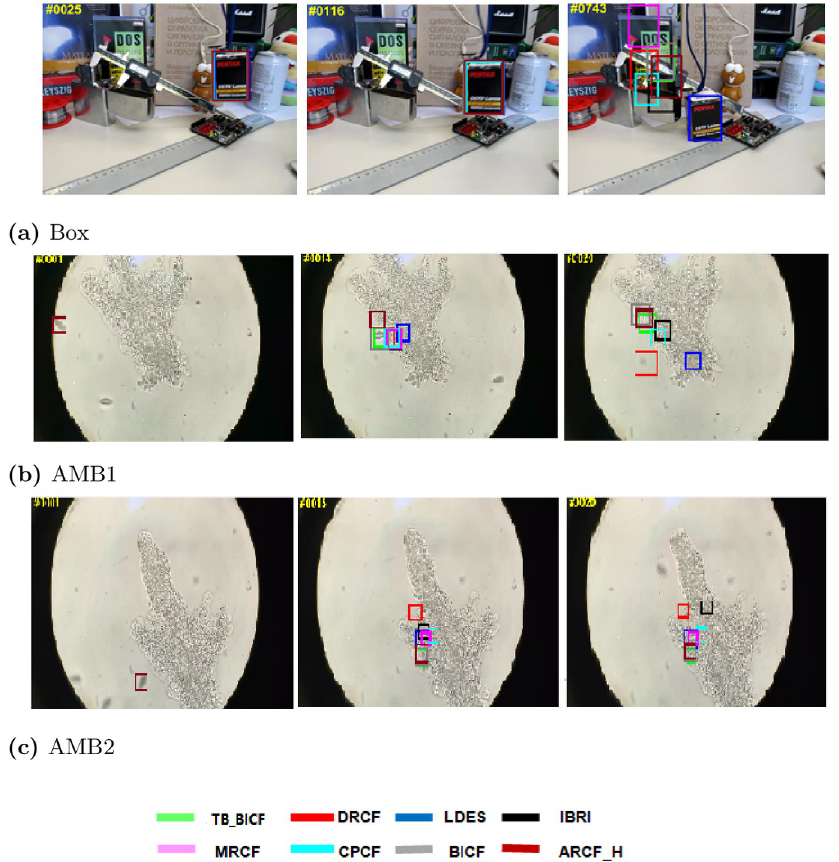
Fig 7. Qualitative assessment of the tested trackers on the a) Box [8], b) AMB1 and c) AMB2 sequences. number of features per sequence. Table 2 lists the the eight trackers’ average frame per second results for each tracker where the running times can be classified into three groups, namely, 1) slow, 2) fast, and 3) normal. The slow group of the largest running times trackers includes LDES and IBRI. The slowest performance of the LDES tracker can be linked to the idea, which is proposed by LDES, of using two boundary boxes to track the object of interest. This pro- posed idea of using two boundary boxes increases the running time drastically. The slow run- ning time of IBRI tracker can be linked to the extended use of historical frames to track the object. The main motivation of IBRI tracker was that most of the existing methods combine the information of only two successive video frames; thus, IBRI extended the number of used frames at the cost of the running time. The fast group of the trackers includes the CPCF tracker only with almost 12 frames per second. The fast performance the CPCF tracker can be justified by utilizing two fast to compute two features, HoG and CN; computing those two features Table 2. The average fps for the eight trackers. Visual Tracking Methods